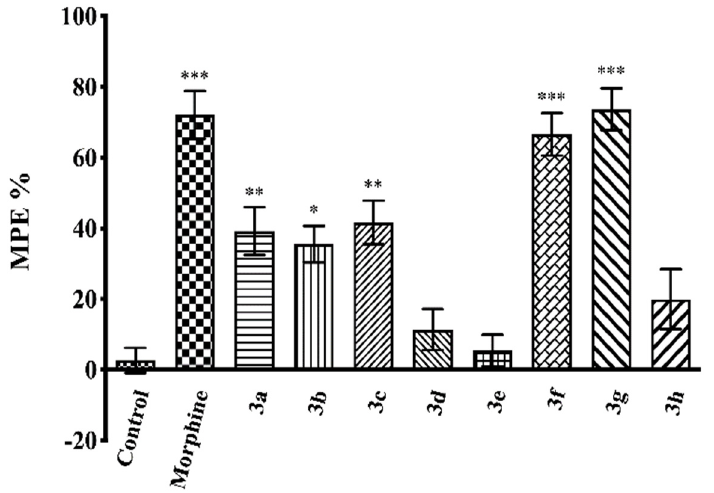
Figure 3. Effects of test compounds ( 3a – 3h , 50 mg/kg, p.o., administered 60 min before testing) and morphine (10 mg/kg, i.p., administered 30 min before testing), on MPE % values in the mice tail-clip test. Significance against control group * p < 0.05, ** p < 0.01, *** p < 0.001. Values are mean ± SEM. One-way ANOVA and post-hoc Tukey’s test, n = 7.